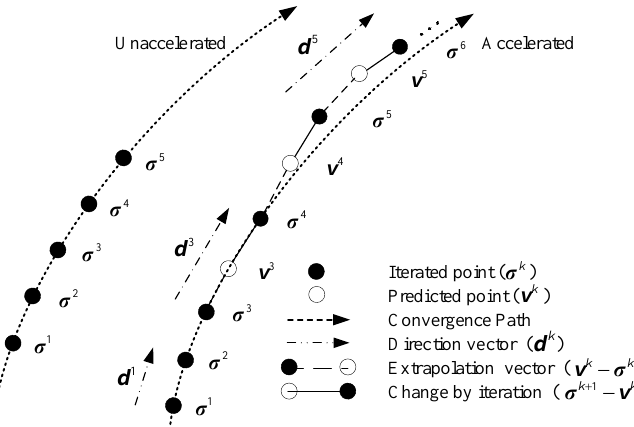
Figure 1. Vector extrapolation